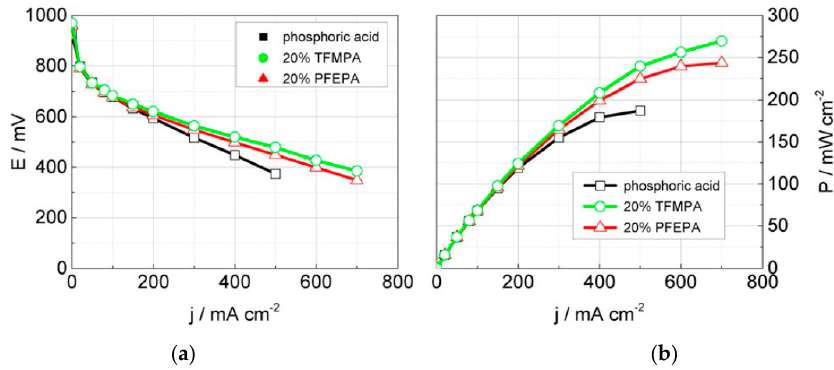
Figure 5. Polarization curves ( a ); and power density curves ( b ) of the HT ‐ PEMFCs with different cathode electrode doping: concentrated phosphoric acid, PFEPA, and TFMPA additives (Reproduced from [144] with permission; Copyright John Wiley and Sons, 2016).